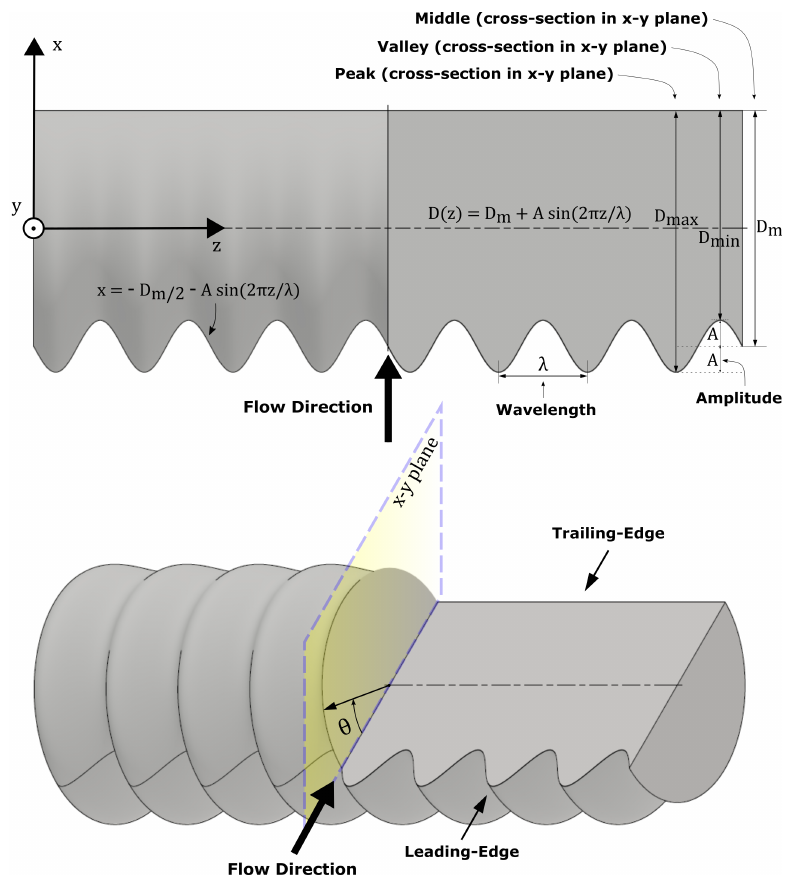
Figure 2. Sectional views—cutting plane ( top ) and three-dimensional view ( bottom )—of the new flow control geometry proposed: the wavy leading-edge cylinder geometry. The illustrative figure presents the main parameters and constructive function in the x – z